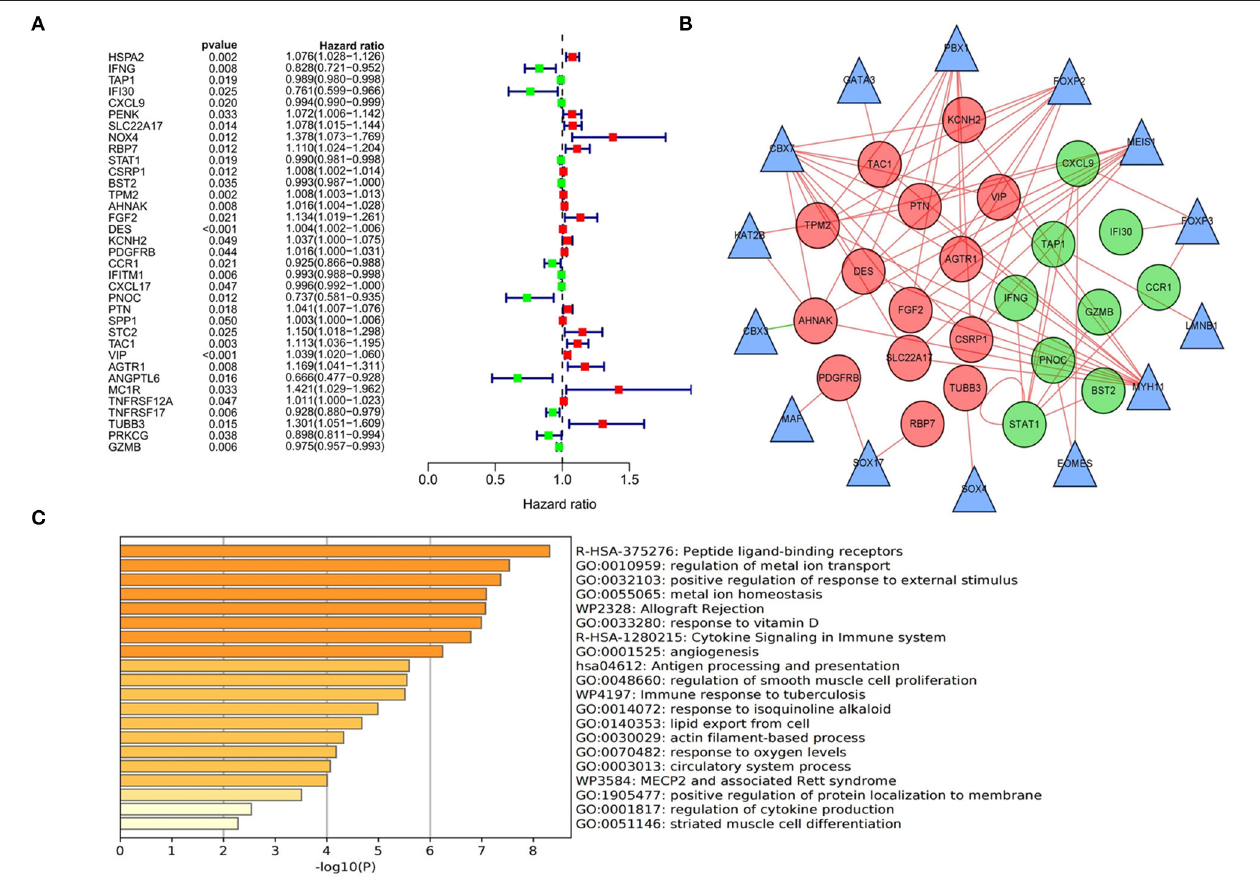
FIGURE 3 | Identification, functional enrichment of PDEIRGs and construction of TF-based regulatory network in GC. (A) A forest diagram of PDEIRGs through univariate Cox analysis. The red mark indicates that HR value of the immune gene is > 1 (high risk), and the green mark indicates that HR value of the immune gene is < 1 (low risk). (B) TF-based regulatory network. The red and green dots represent PDEIRGs, the triangles represent DETFs that correlated with PDEIRGs in terms of their mRNA expression. (C) Functional analysis.